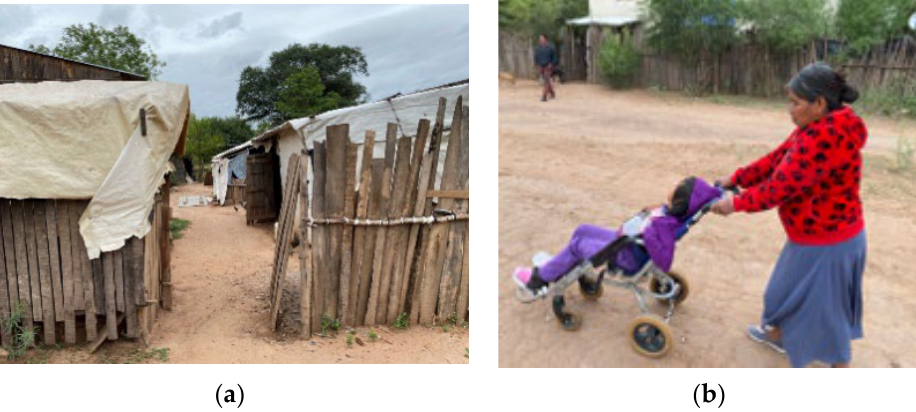
Figure 3. Local environs and wheeled mobility products which can traverse unpaved ground. ( a ) Local environs. ( b ) Wheeled mobility on unpaved ground.